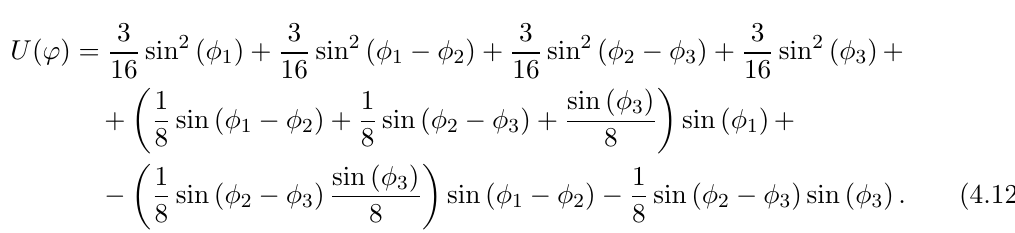
which, for the choice (cid:13)